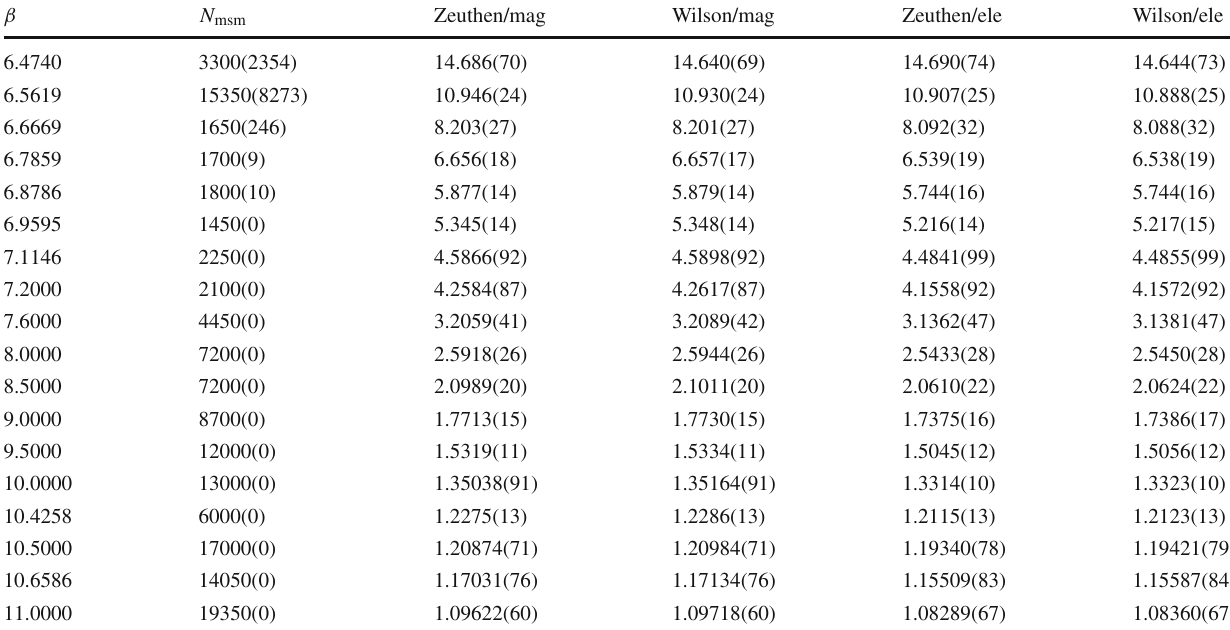
Table 10 GF coupling data for L / a = 32